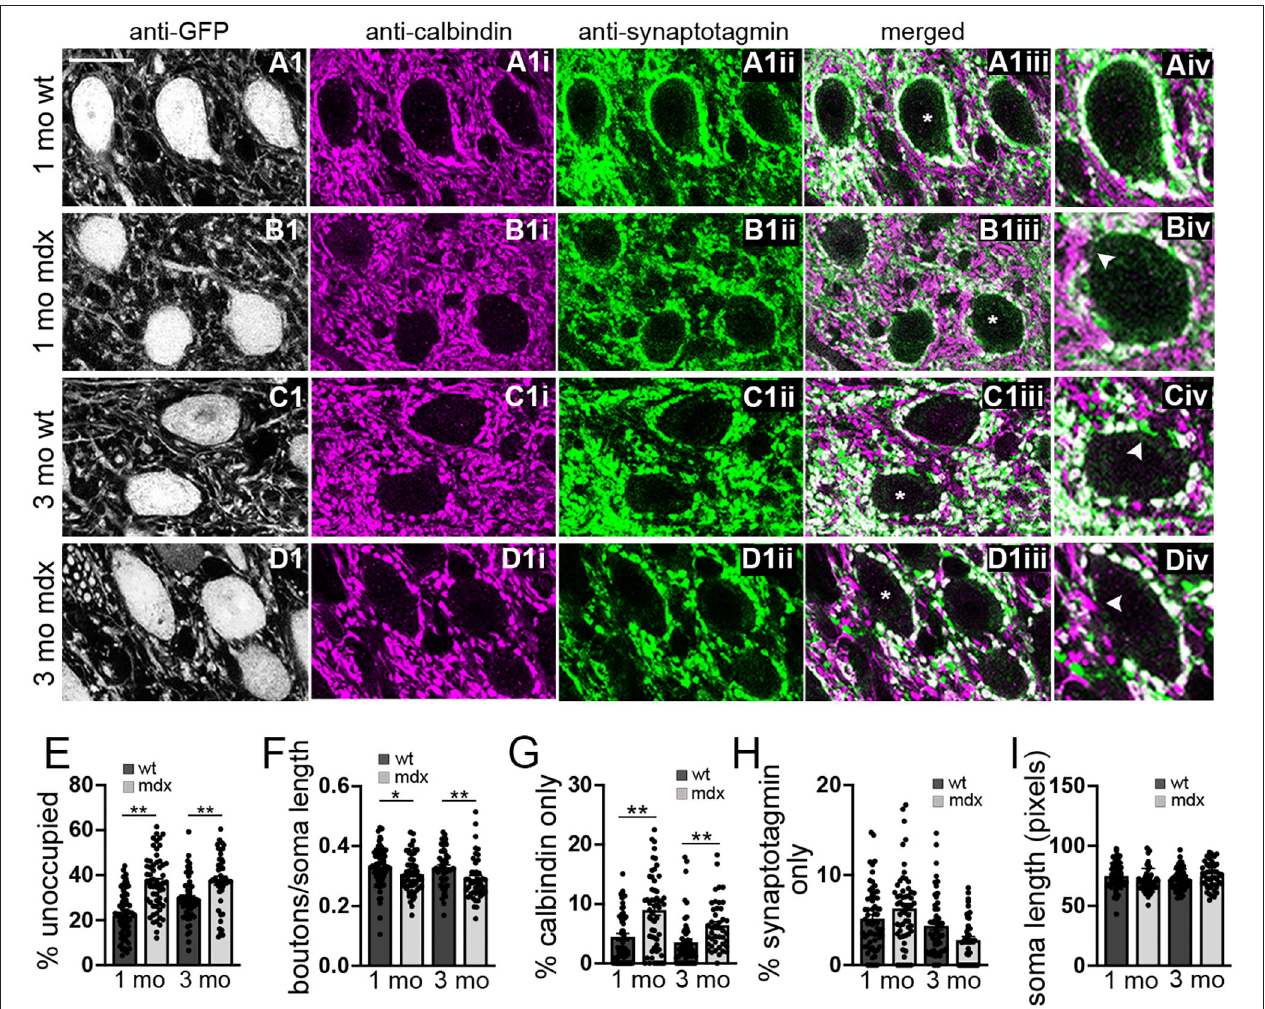
FIGURE 2 | The number of anatomically defined PC boutons contacting CbN neurons is reduced in mdx mice. (A–D) Representative 40x confocal sagittal cerebellar slice images of YFP + CbN neurons (A1–D1) and PC-CbN synapses from 1- and 3-month-old wild-type (A,C) and mdx (B,D) mice. Sections were immunolabelled for GFP (grayscale channel, labeling glutamatergic neurons, A1–D1 ), calbindin (magenta channel, PC marker, A1i–D1i ) and synaptotagmin (green channel, presynaptic marker, A1ii–D1ii ). Merged images of calbindin and synaptotagmin labeling are also shown (A1iii–D1iii) . (Aiv–Div) Enlarged CbN somata (indicated by asterisk (*) in A1iii–D1iii ) showing the area around the CbN soma lacking PC boutons (arrowhead in B1iv ), area occupied with PC axons (calbindin—only staining, arrowhead in D1iv ) and area occupied by non-PC boutons (synaptotagmin—only staining, arrowhead in C1iv ). Scale bar: 20 µ m. (E–H) Summary graphs of mean values for length of CbN soma lacking PC boutons ( E , % unoccupied), number of PC boutons surrounding each soma ( F , boutons/soma length), and length of soma contacted by structures labeled by either calbindin only (G) or synaptotagmin only (H) . Data from 1- or 3-month-old wild-type [dark gray bars, n (1 mo) = 63, n (3 mo) = 53 cells] and mdx [light gray bars, n (1 mo) = 58, n (3 mo) = 43 cells] mice are shown. Three mice were analyzed per age and genotype. All values are normalized to the soma circumference of each cell. The circumference of YFP + somata were not different between wild-type and mdx cells at either age (I) . Error bars indicate SEM. * p ≤ 0.05, ** p ≤